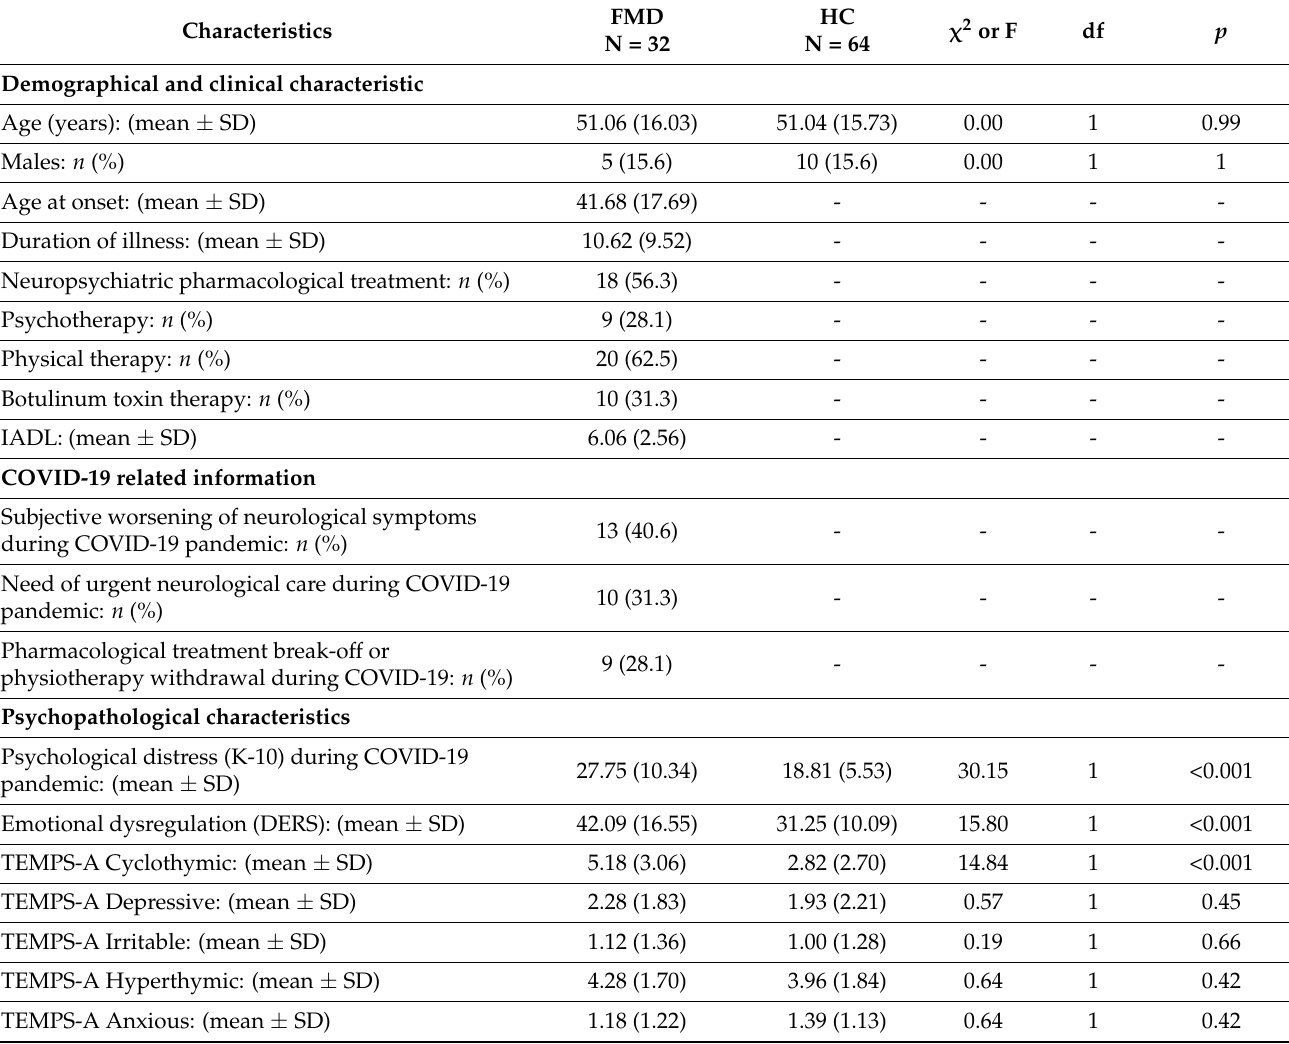
Table 1. Demographic, clinical and psychopathological characteristics of the sample and COVID-19- related